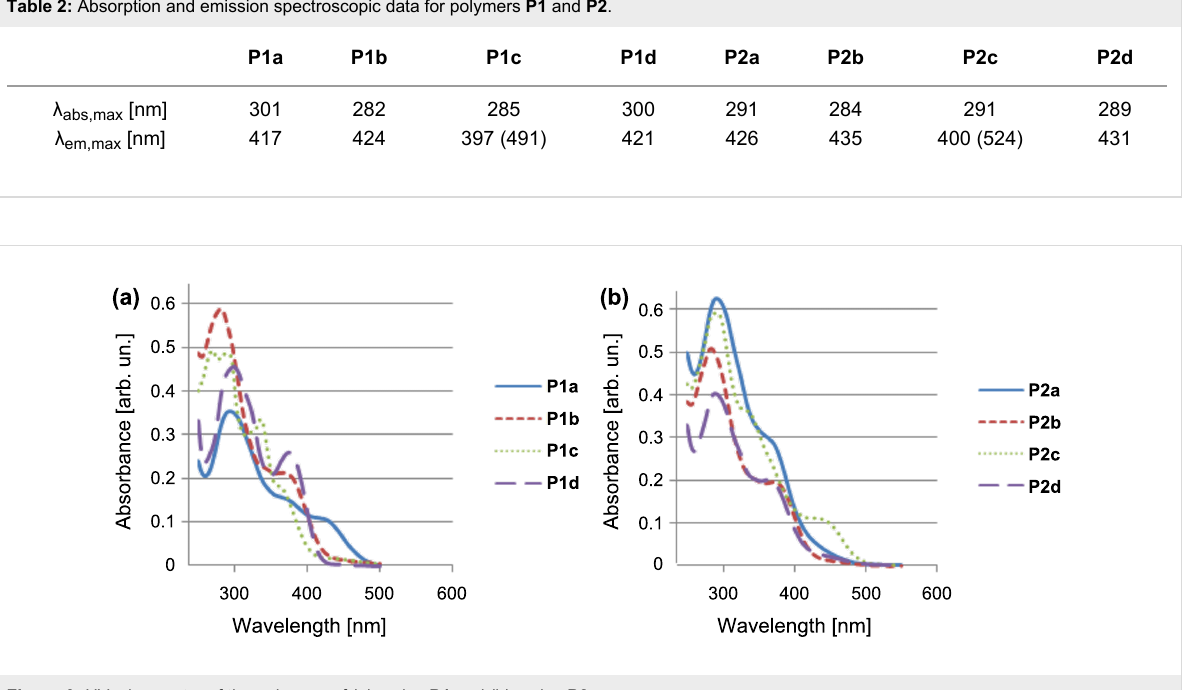
Figure 6: UV–vis spectra of the polymers of (a) series P1 and (b) series P2 .